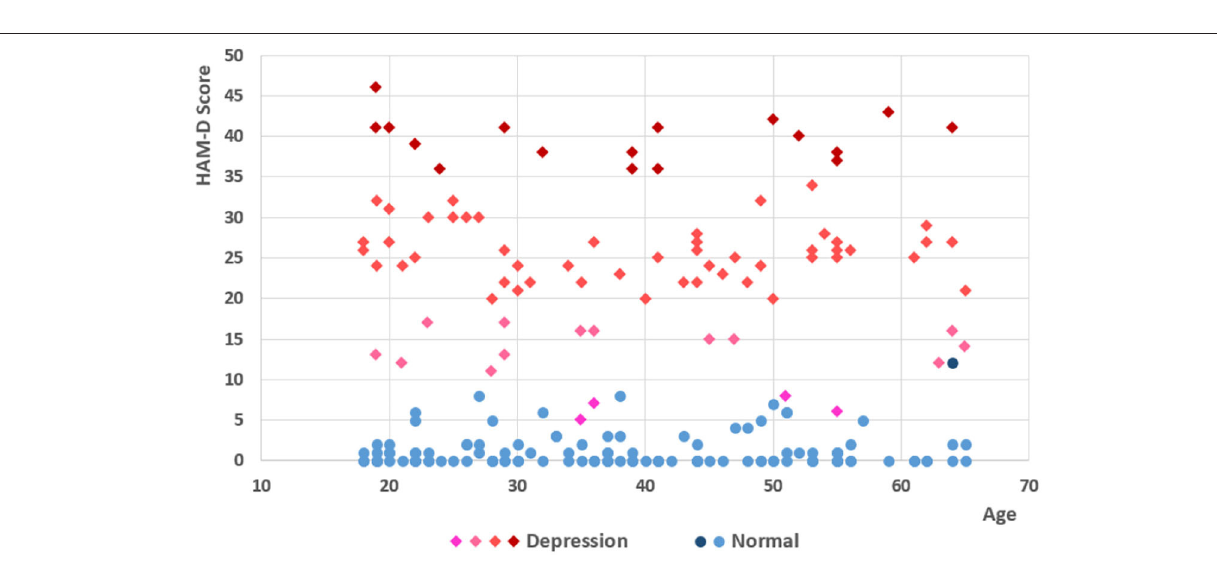
joints in terms of the X and Y coordinate space axis, shown in Figure 4 . In order to extract and pre-process skeleton data custom, we developed a skeleton-extractor program based on .net core 3.0. As a non-intrusive extracting method, shortening the necessary recording sequence would improve its practical value, so we tried to select crucial series from each participant during